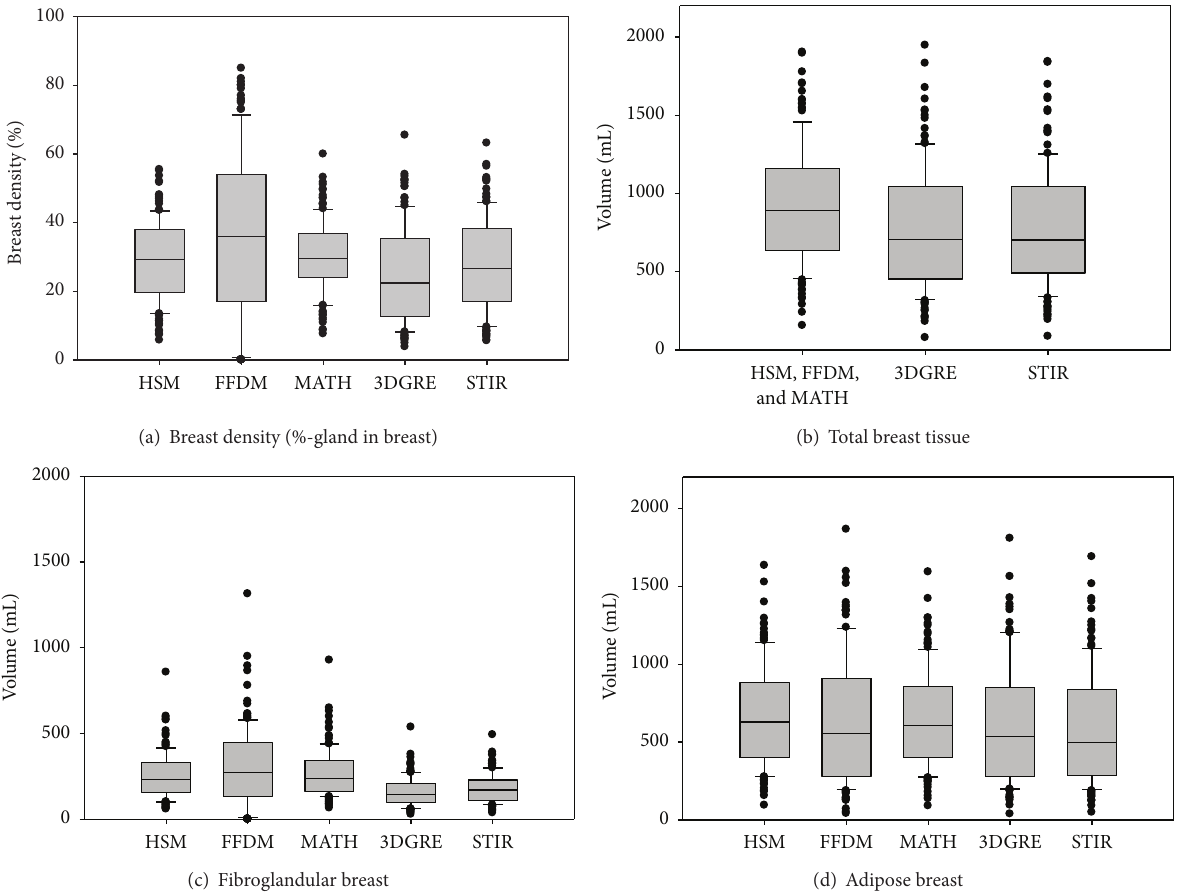
Figure 1: Interquartile box plots of breast density (a), total breast tissue volume (b), fibroglandular breast tissue volume (c), and adipose breast tissue (d) in 137 premenopausal women as measured by a histogram segmentation method (HSM), a full field digital mammography unit (FFDM) unit, a mathematical algorithm (MATH), a 3D gradient-echo (3DGRE) pulse sequence MRI, and a short tau inversion recovery pulse sequence (STIR) MRI. For the spread and distribution, consult histograms in Figure